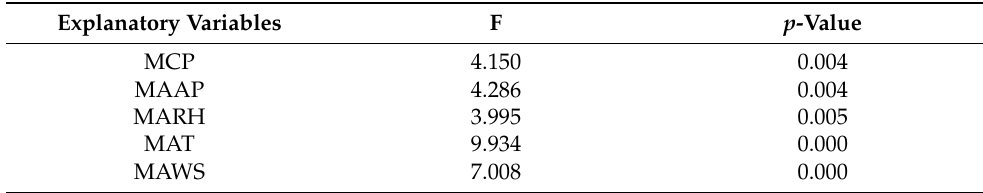
Table 5. Non-stationarity of parameters in the geographically and temporally weighted regression (GTWR)